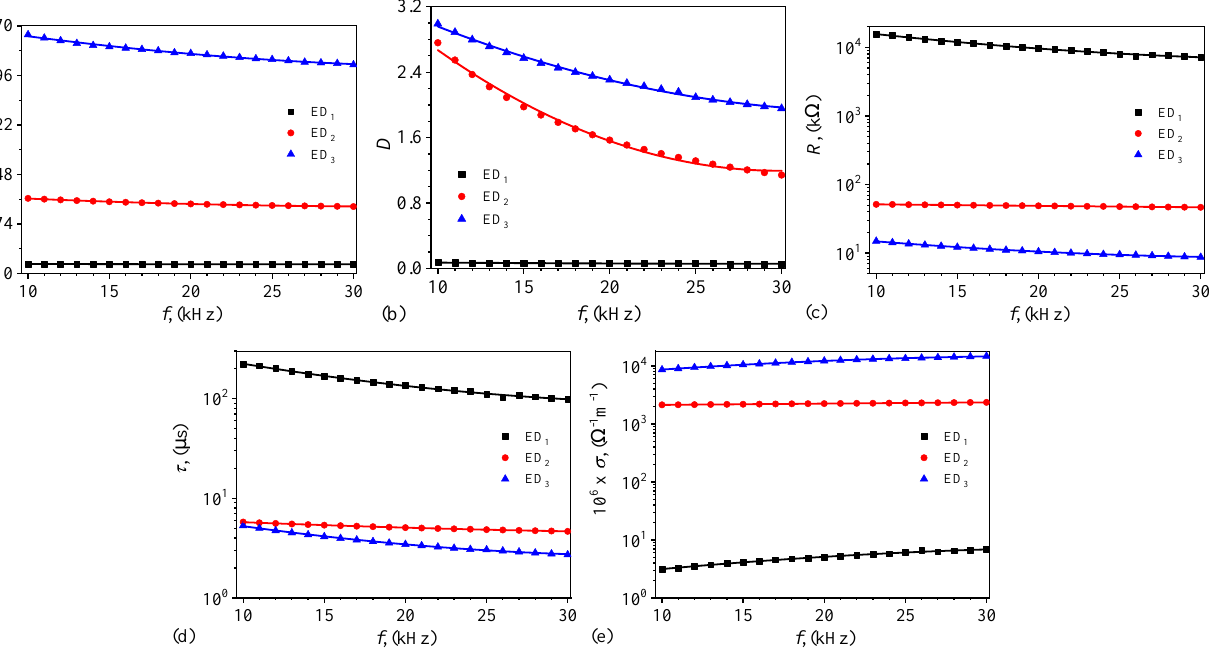
Figure 8. Variations in ( a ) capacitance C , ( b ) dielectric loss tangent D , ( c ) resistance R , ( d ) time constant τ , and ( e ) electrical conductivity σ , of the electrical devices without CI microparticles (i.e., ED 1 , ED 2 , and ED 3 ), with the frequency f of a sinusoidal electric field at B = 0 mT. Using Equation (3), the time constant τ of the electrical device, which represents a measure of the storage duration of the electromagnetic energy between the electrodes of the device, is obtained according